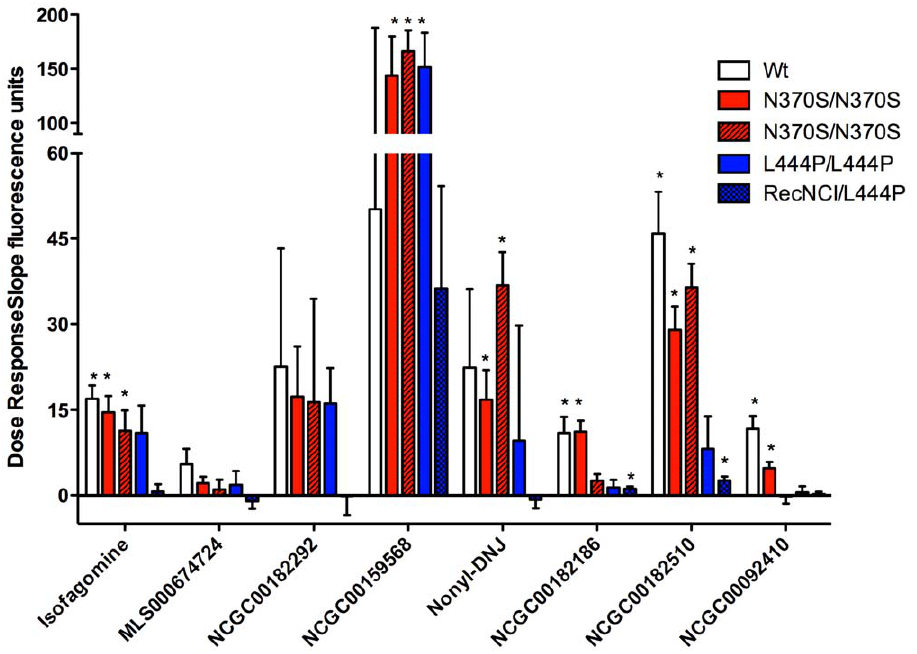
Figure 8. Potency of selected compounds in the WT and N370S mutant enzyme assay with NaTC or SapC. Compound NCGC0092410 (NCGC), discovered in the recombinant WT HTS, inhibited the WT enzyme much better than N370S in NaTC (A), but showed less inhibition of WT enzyme in the SapC assay (B). Compound MLS000393962 (MLS) (C,D), identified in the N370S/N370S spleen HTS, inhibited the WT recombinant enzyme, and had no effect on the recombinant N370S enzyme with the addition of NaTC (C). However, in the presence of SapC (D), there was an enhanced inhibitory effect on the WT enzyme as well as the N370S enzyme. * No trendline fit possible.